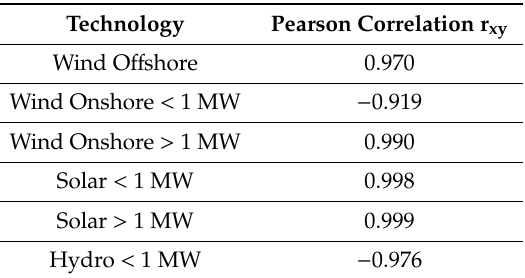
Table 12. Correlation of LCOE values and reference prices at Polish RES auctions in 2016–2025 (values for 2019–2025 based on linear regression forecast). for 2019–2025 based on linear regression